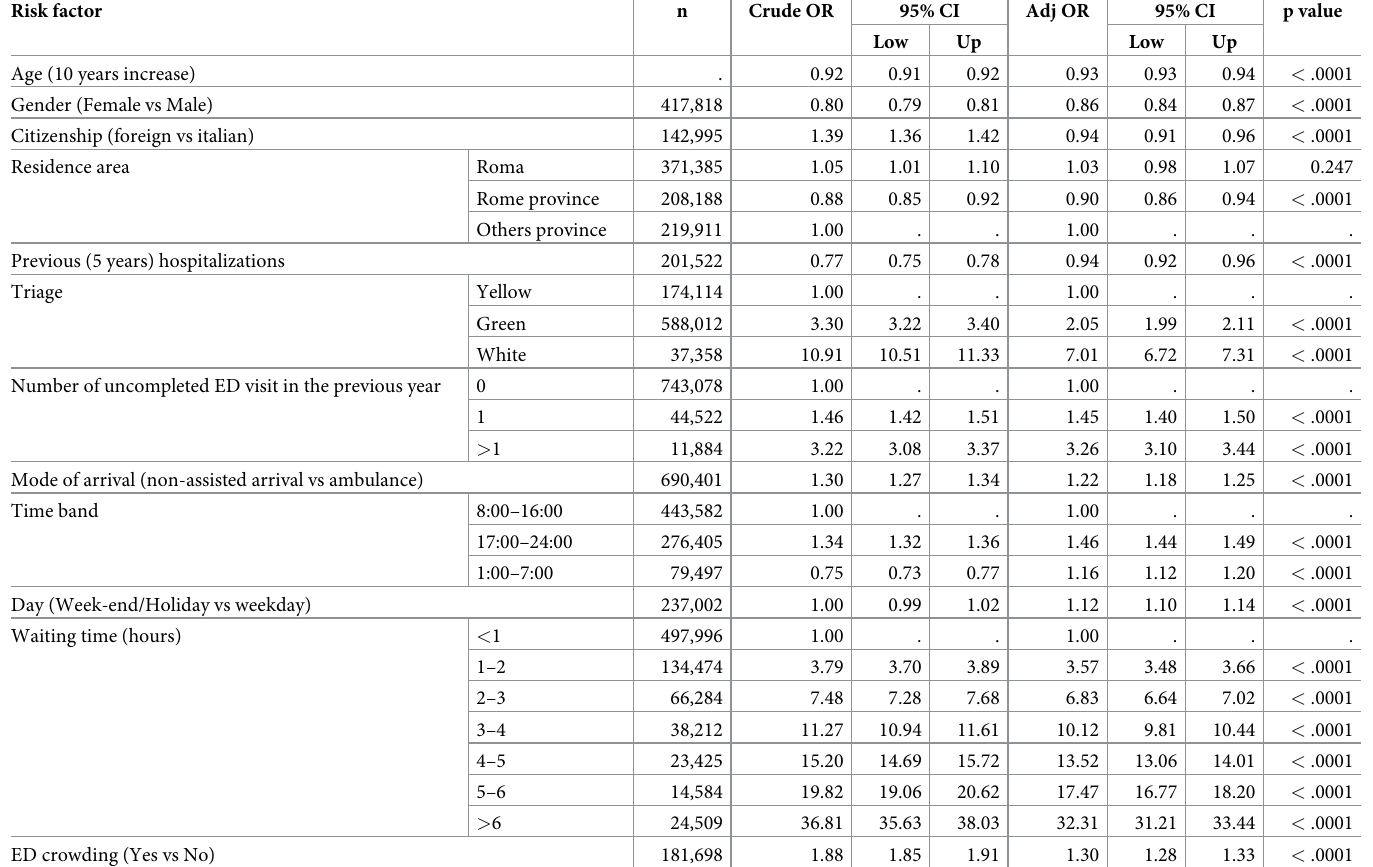
Table 2. Risk factors of leaving without being seen (LWBS)—results from a multi-level logistic regression model. Risk factor n Crude OR